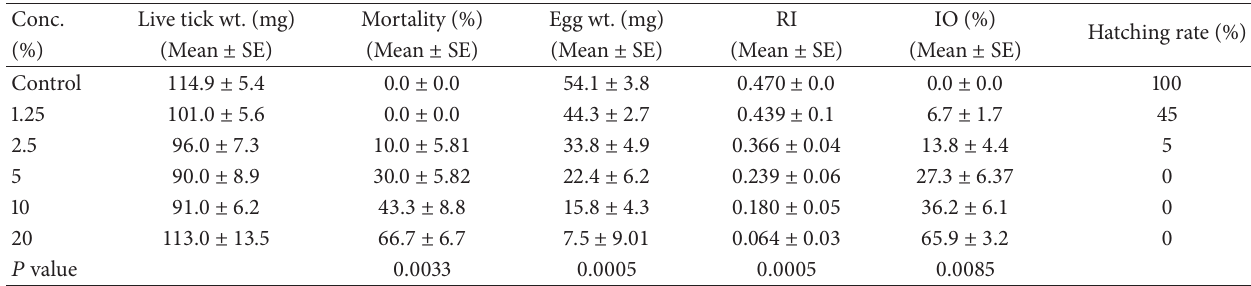
Table 2: Tick weight, percent mortality, egg weight, reproductive index (RI), and inhibition of oviposition (IO) of R. microplus adults exposed to different concentrations of the ethanolic extract of A. absinthium . Conc. Live tick wt.